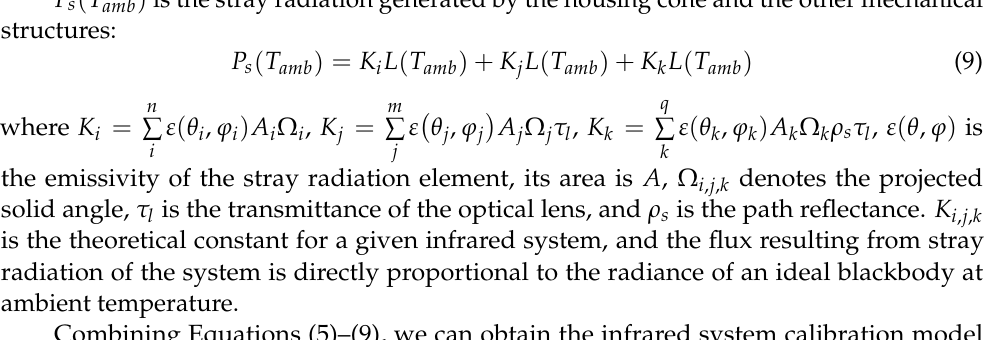
Figure 3. Geometry of stray radiation. Figure 3. Geometry of stray radiation. ① self-radiation from the optical lens; ② radiation received Figure 3. Geometry of stray radiation. ① self-radiation from the optical lens; ② radiation received Figure 3. Geometry of stray radiation. ① self-radiation from the optical lens; ② radiation received Figure 3. Geometry of stray radiation. ① self-radiation from the optical lens; ② radiation received Figure 3. Geometry of stray radiation. ① self-radiation from the optical lens; ② radiation received directly by the detector from mechanical structures such as the housing cone; ③ radiation from directly by the detector from mechanical structures such as the housing cone; ③ radiation from directly by the detector from mechanical structures such as the housing cone; ③ radiation from directly by the detector from mechanical structures such as the housing cone; ③ radiation from directly by the detector from mechanical structures such as the housing cone; ③ radiation from the housing cone and other mechanical structures through the lens to reach the detector; ④ radia- the housing cone and other mechanical structures through the lens to reach the detector; ④ radia- the housing cone and other mechanical structures through the lens to reach the detector; ④ radia- the housing cone and other mechanical structures through the lens to reach the detector; ④ radia- housing cone and other mechanical structures through the lens to reach the detector; the housing cone and other mechanical structures through the lens to reach the detector; ④ radia- tion from the housing cone and other mechanical structures after reflection through the lens into tion from the housing cone and other mechanical structures after reflection through the lens into tion from the housing cone and other mechanical structures after reflection through the lens into tion from the housing cone and other mechanical structures after reflection through the lens into tion from the housing cone and other mechanical structures after reflection through the lens into the housing cone and other mechanical structures after reflection through the lens into the the detector. the detector. the detector. the detector. the detector.